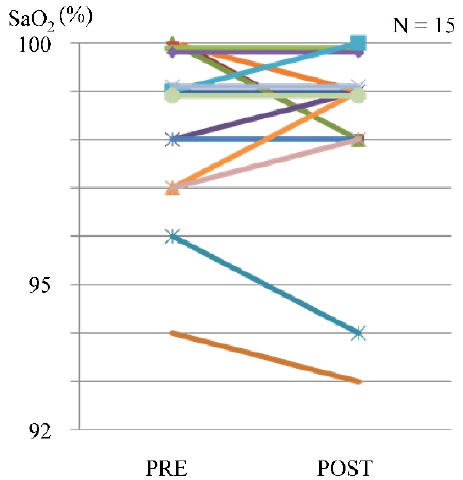
Figure 5. Blood oxygen saturation level before and after exercise using the leg exercise apparatus. Regarding pain after the first LEX exercise, the mean VAS score was 38.5 (range, 0–85) (Figure 6).